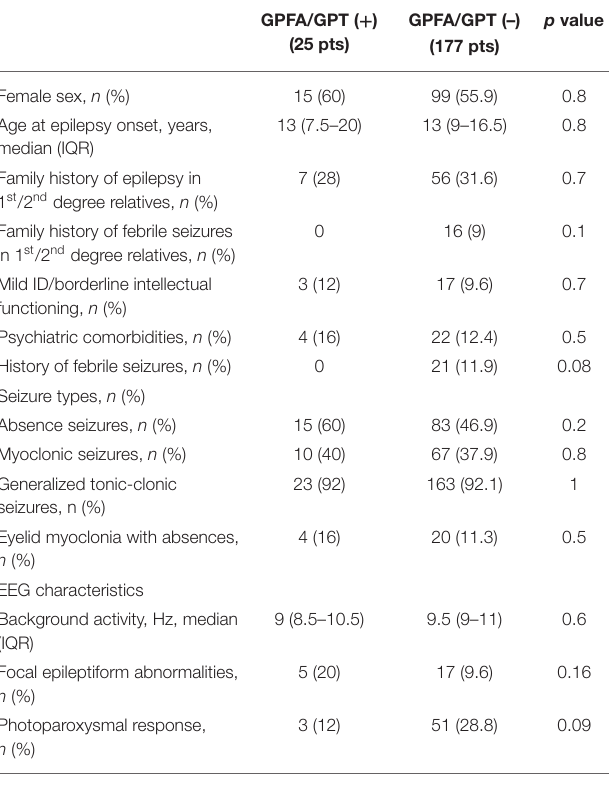
TABLE 3 | Multivariable logistic regression analysis using 2-year remission at the last medical observation as a dependent variable.